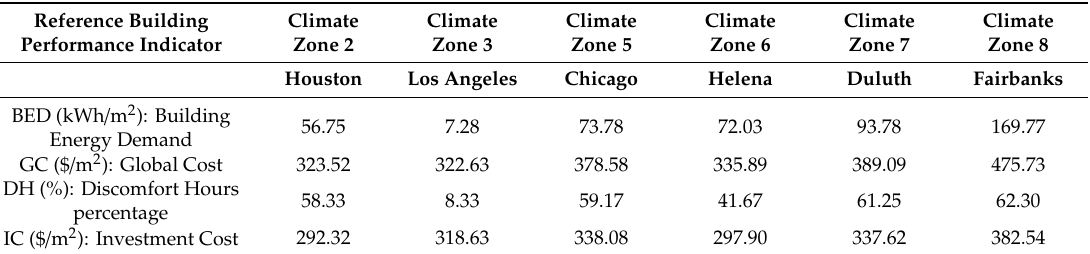
Table 11. Performance indicators for residential building design in typical cities of the United